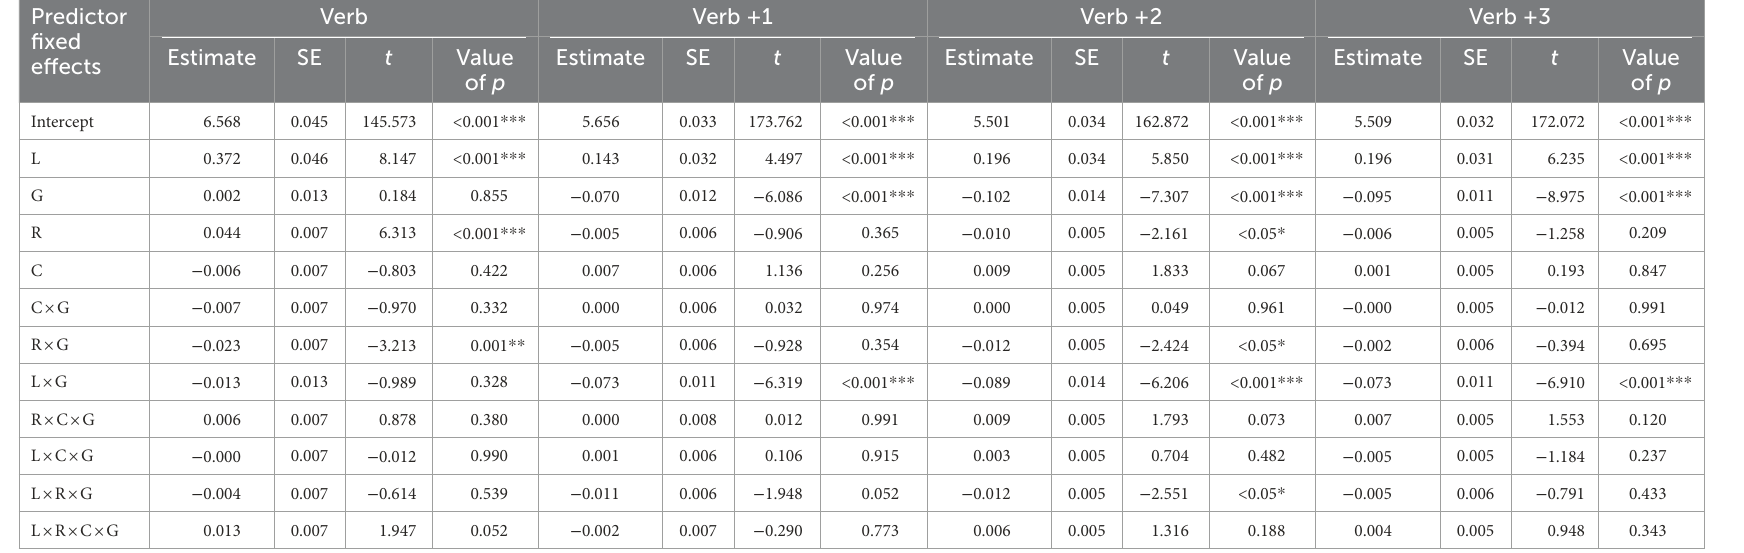
TABLE 3 Summary of the linear mixed effect models for the comparison between adverb-verb and subject-verb violations. Predictor